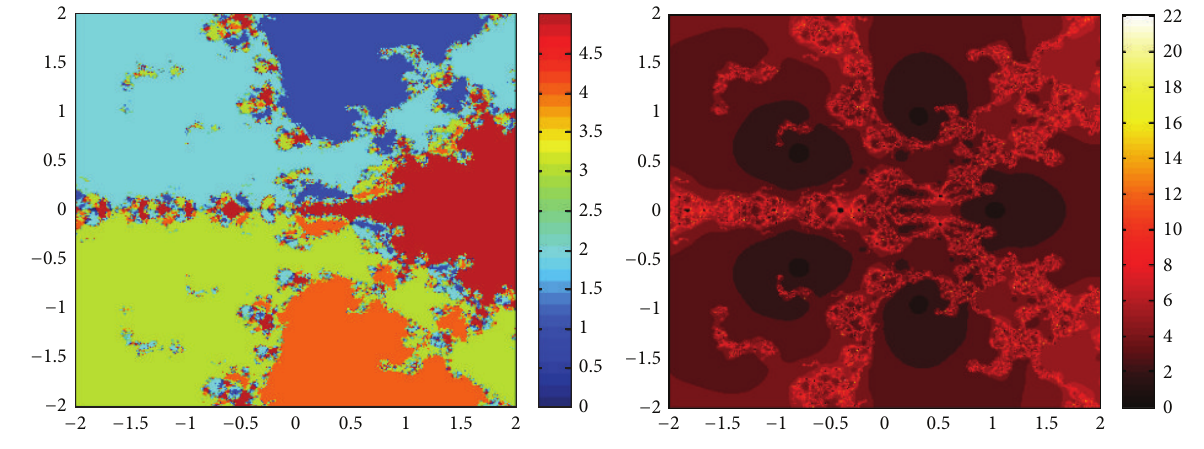
Figure 9: Basins of attraction of (32) for 𝑝 5 (𝑥)